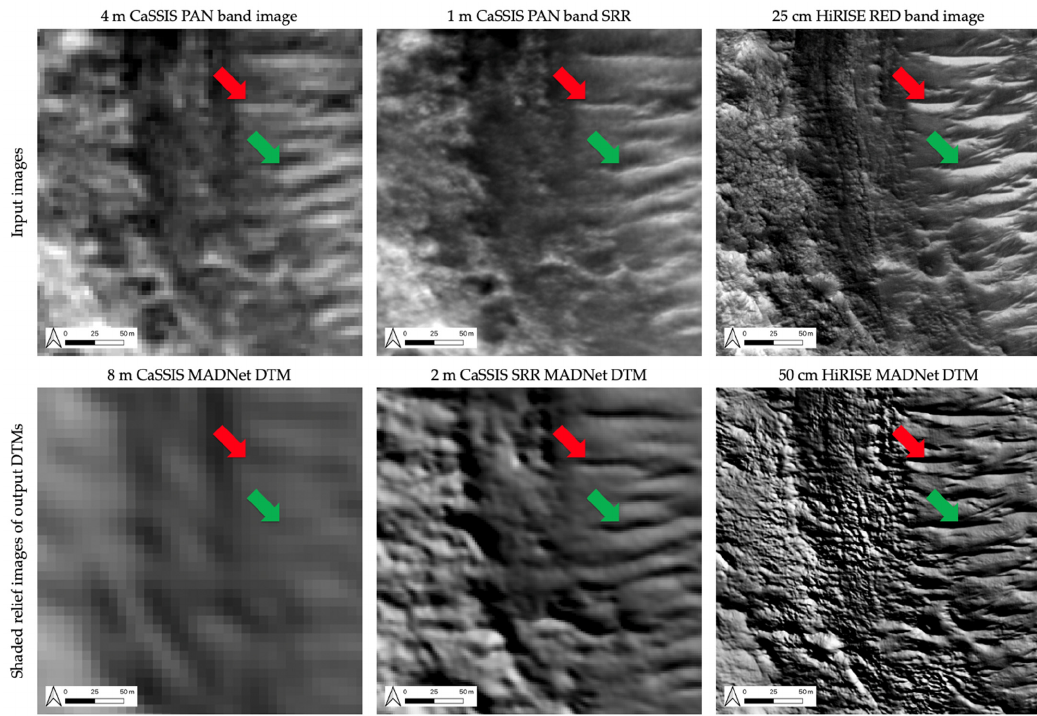
Figure 12. Images and shaded relief images of the corresponding DTM products showing a portion (south-west corner) of a small crater (centred at 24.3350°W, 18.0716°N) of the test site at Oxia Planum. 1st row: 4 m/pixel CaSSIS PAN band image (MY35_009481_165_0_PAN), 1 m/pixel CaSSIS PAN band SRR image, and 25 cm/pixel HiRISE RED band PDS ORI (ESP_039299_1985_RED_A_01_ORTHO); 2nd row: shaded relief images (using similar illumination parameters as the HiRISE PDS ORI, i.e., 225° azimuth, 30° altitude, 2× vertical exaggeration) of the 8 m/pixel CaSSIS MADNet DTM, 2 m/pixel CaSSIS SRR MADNet DTM, and 50 cm/pixel HiRISE MADNet DTM. Red arrows point to an exemplar of the super-resolved features and their topography that are considered less accurate compared to the HiRISE images and DTMs. Green arrows point to an exemplar of the super-resolved features and their topography that are considered more accurate compared to the HiRISE images and DTMs.